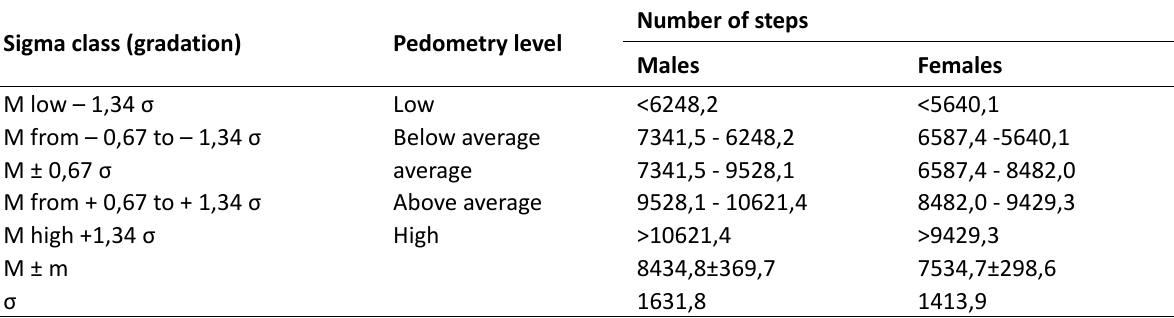
Table . The estimation scale of the daily pedometry of senior students Sigma class (gradation)